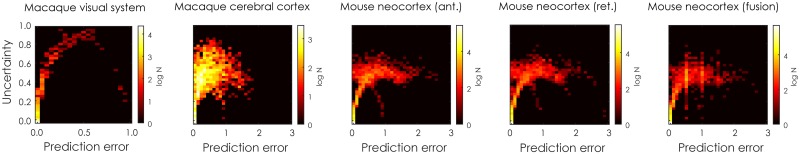
Prediction error and uncertainty.The relationship between prediction error and uncertainty, by the LSM. Colors are determined by the number of connections that lie within each cell; warmer colors indicate more connections. Counts are log-transformed for visualization. Note that for the mouse neocortex data fusion case, the prediction error is averaged over errors with the anterograde and retrograde data.